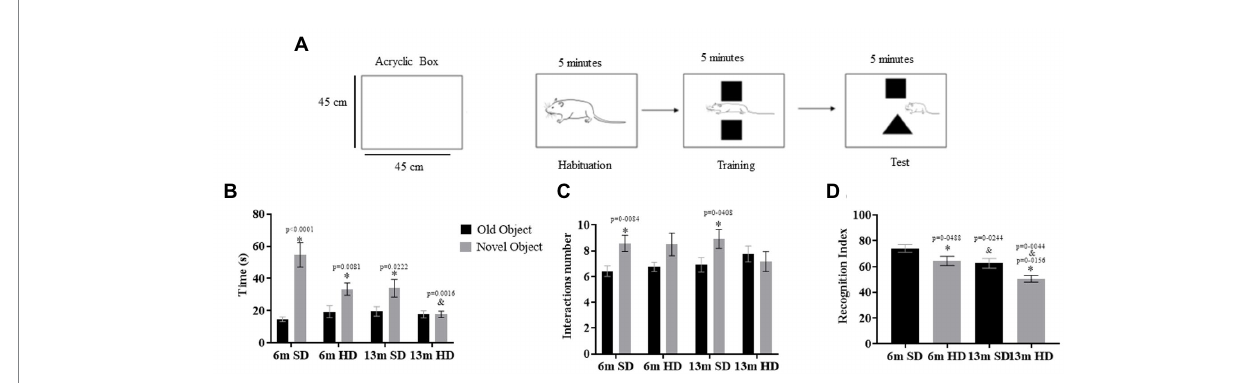
FIGURE 6 Novel object recognition test. (A) Schematic representation of protocol for a novel object recognition test. Familiar and novel object interaction time (B) , interactions number (C) , and recognition index (D) determined in rats fed with SD and HD at 6 and 13 months of age ( n = 12 SD and n = 12 HD). Each bar represents the mean ± SD. The data were analyzed by two-way ANOVA and Tukey’s post hoc test. The significant differences between groups with respect to the SD are marked with ∗ , and differences at different ages are marked with & p <